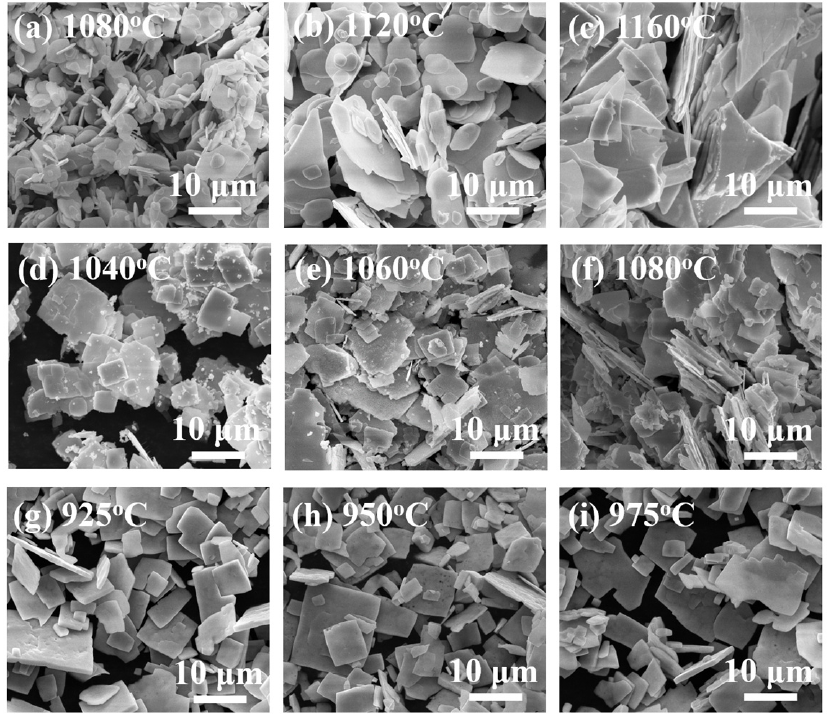
Figure 1. FE-SEM images of ( a – c ) Bi 4 Ti 3 O 12 precursor, ( d – f ) BaBi 4 Ti 4 O 15 precursor, and ( g – i ) BaTiO 3 mesoscale particles synthesized at different temperatures.